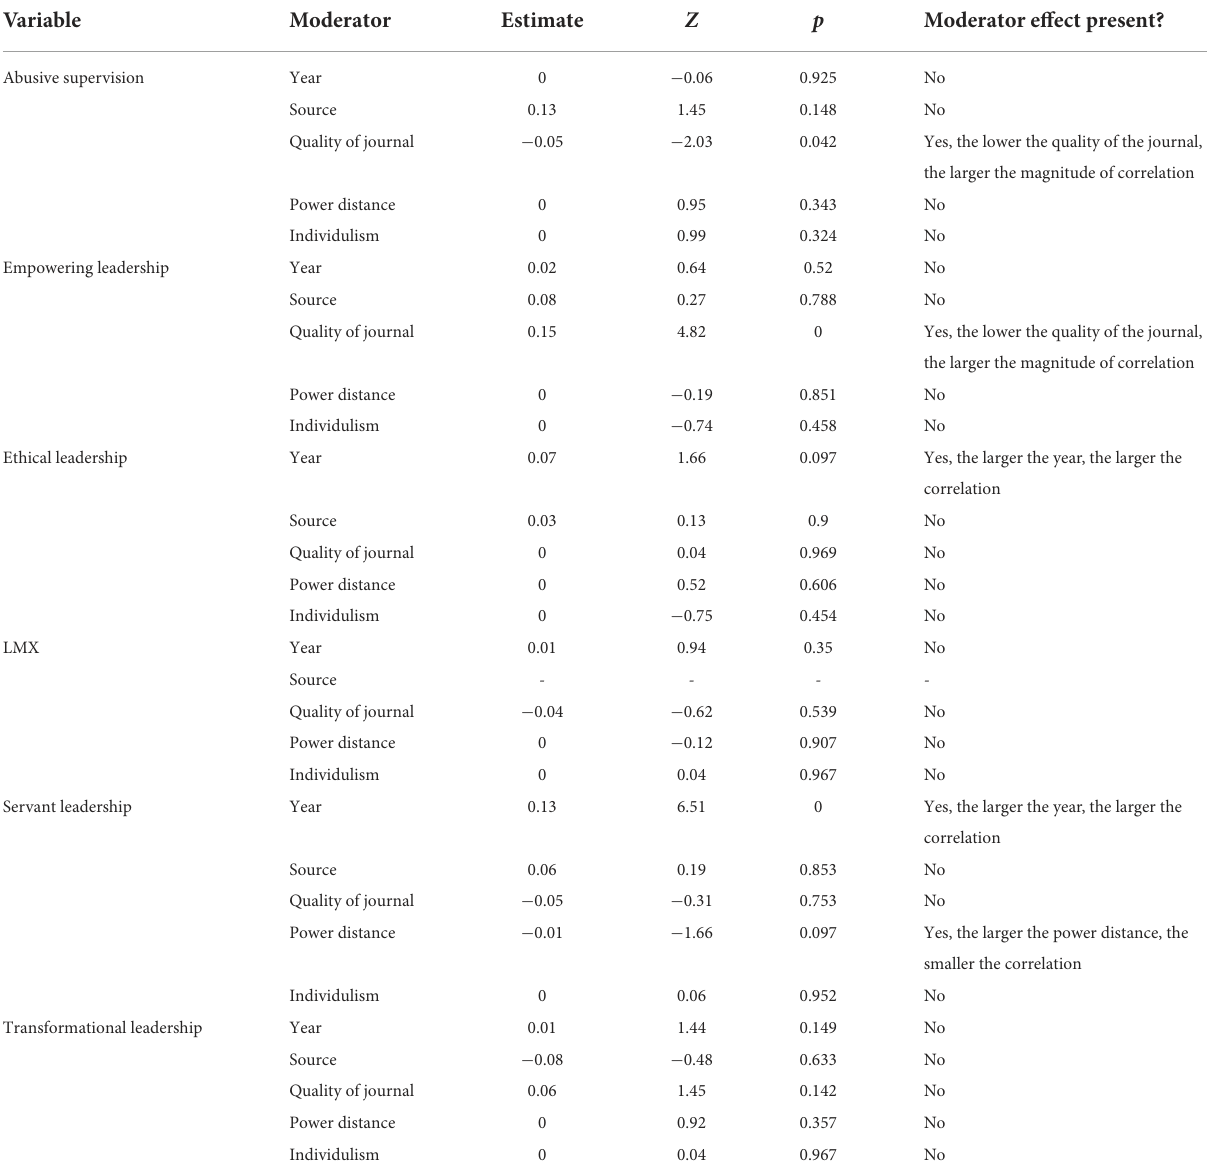
TABLE 6 Moderation